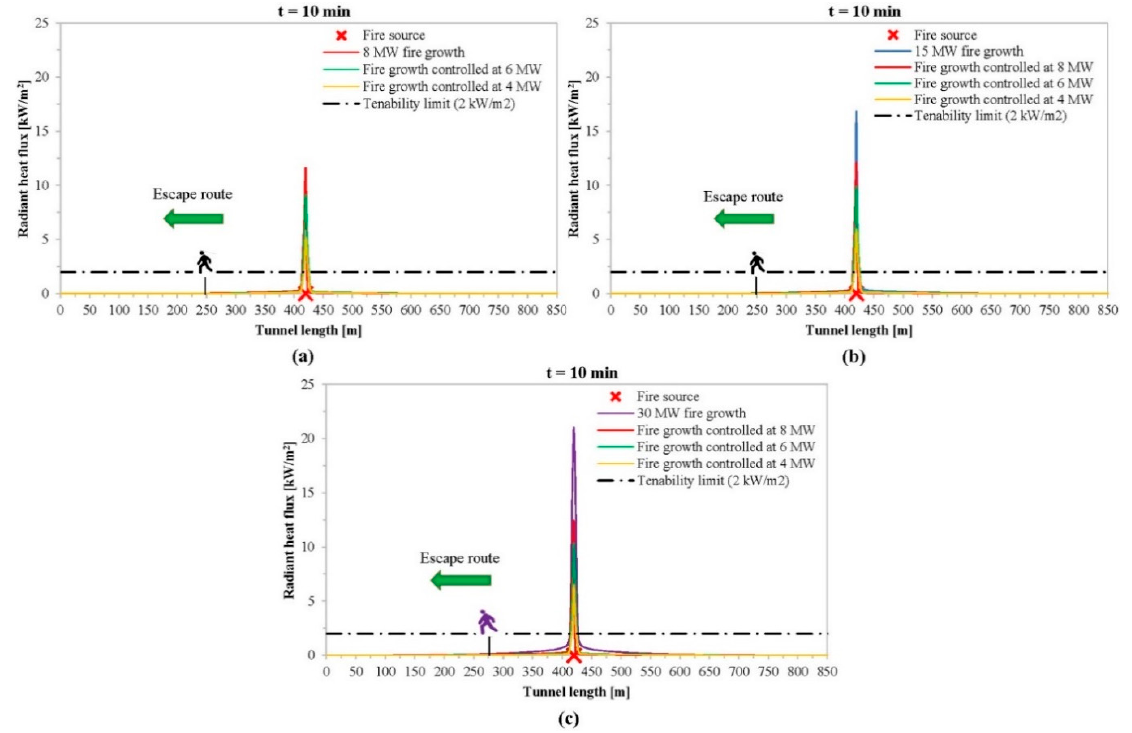
Figure 11. Profiles of longitudinal temperature at a height of 2 m along the escape route on the road carriageway after 10 min from the fire’s start when the burning vehicle is at 420 m from portal A and the micronized water system is activated before that the fire growth achieves values of: ( a ) HRR max = 8 MW, ( b ) HRR max = 15 MW, ( c ) HRR max = 30 MW.